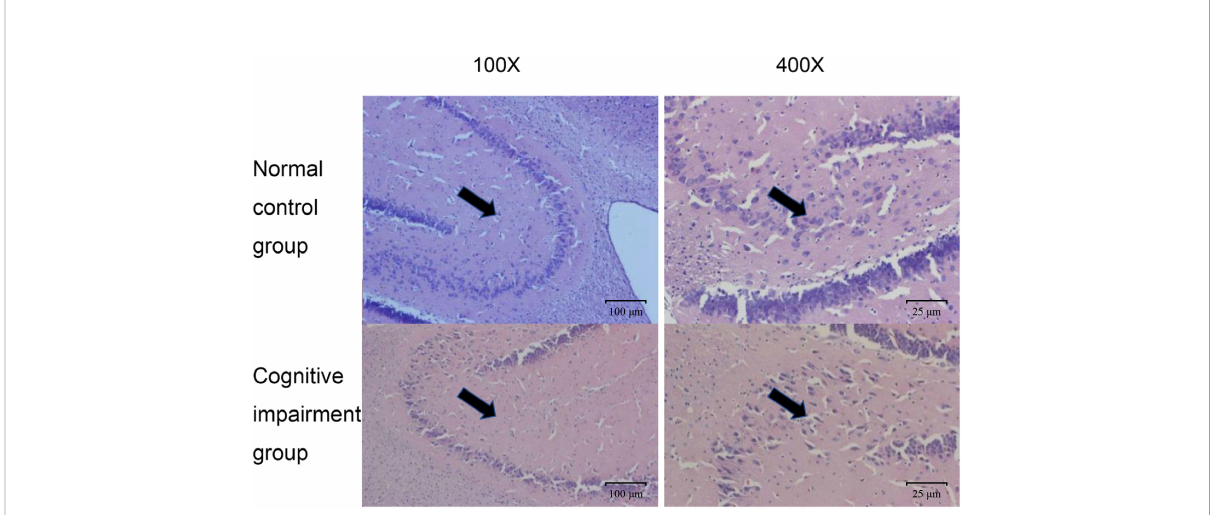
FIGURE 2 Comparison on pathological changes of hippocampal neurons from rats in the normal control group and the cognitive impairment group. Representative images of HE staining results from the normal control group and the cognitive impairment group. The hippocampal neurons were clear in structure, normal in size, and stained light blue; while those in the cognitive impairment group were not arranged orderly, largely degenerated, and necrotic. Magni fi cation, 100 × and 400 ×, as